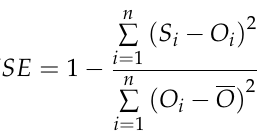
Figure 8. Initial conditions of simulation model.